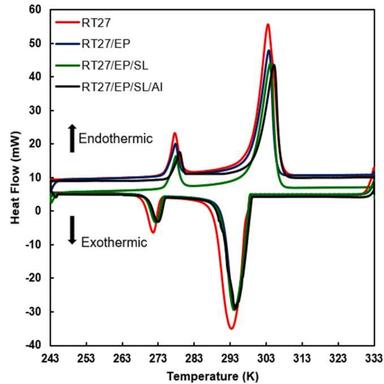
DSC heating and cooling curves of RT27 paraffin and different composites (RT27/EP, RT27/EP/SL, RT27/EP/SL/Al) at 10 k/min.